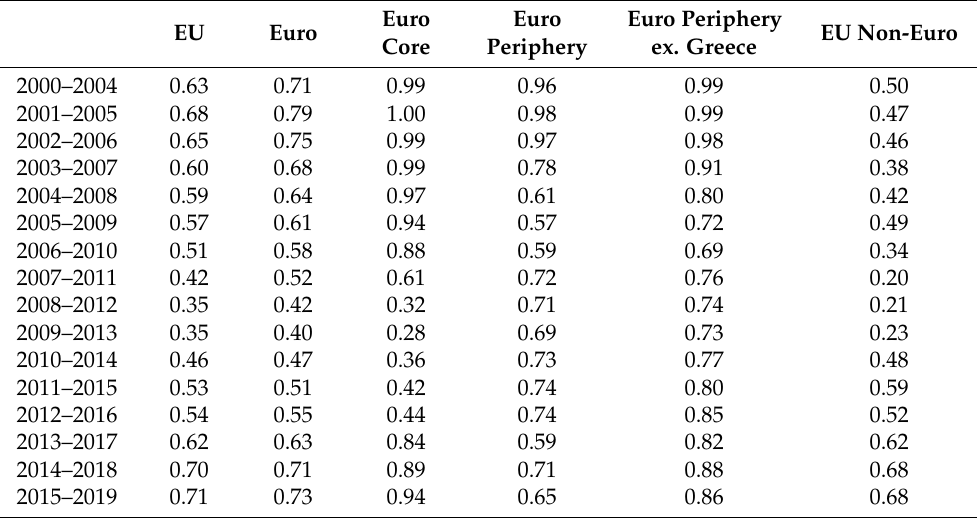
Table 9. Yields on 10-year government bond—average of country-level correlation coefficients for different country groups. EU Euro